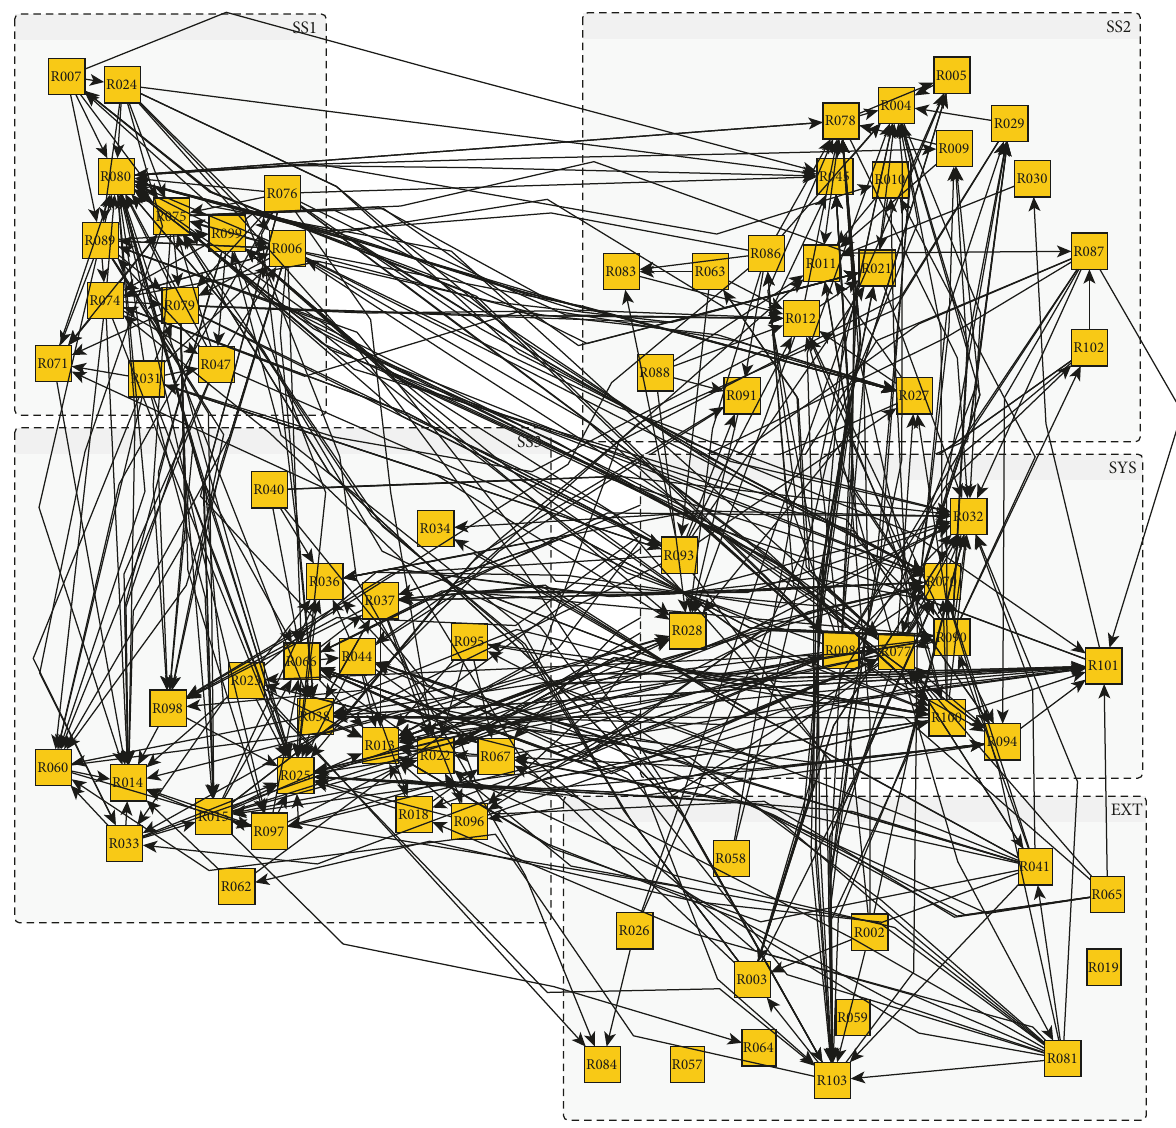
Figure 2: Representation of the existing risk